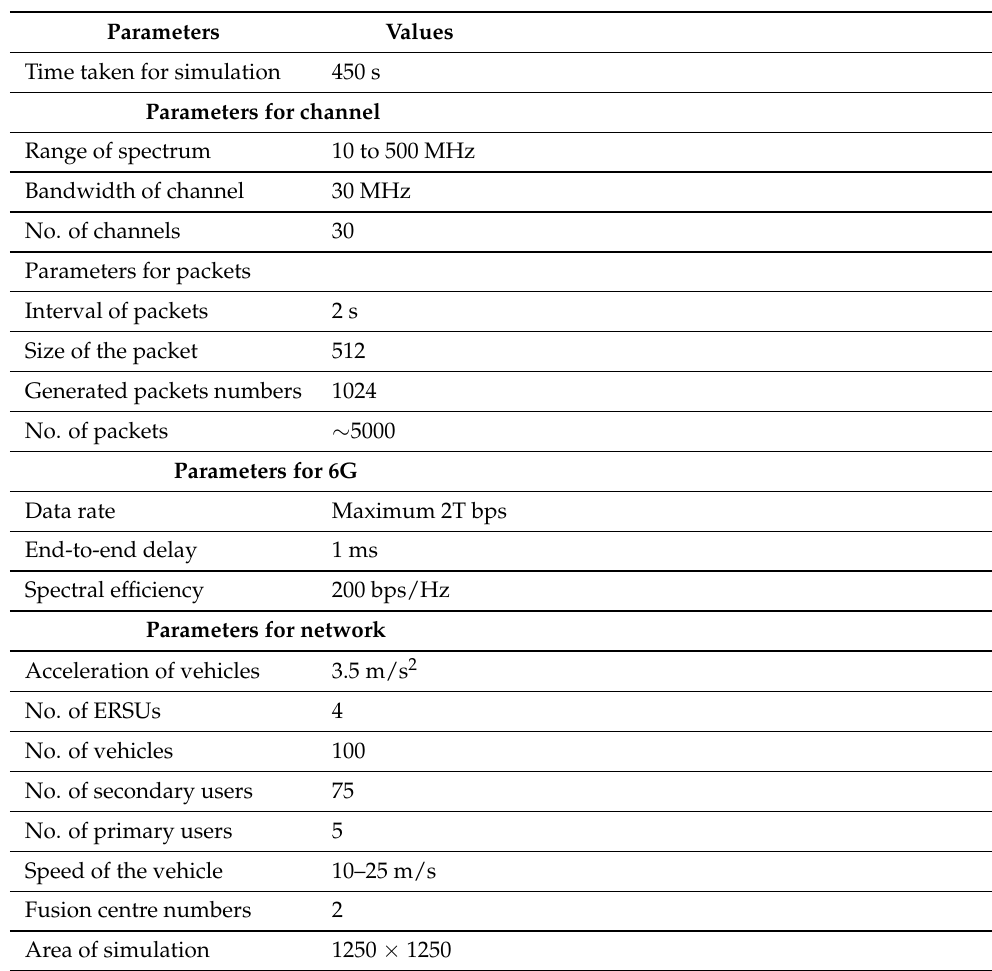
Table 4. Simulation